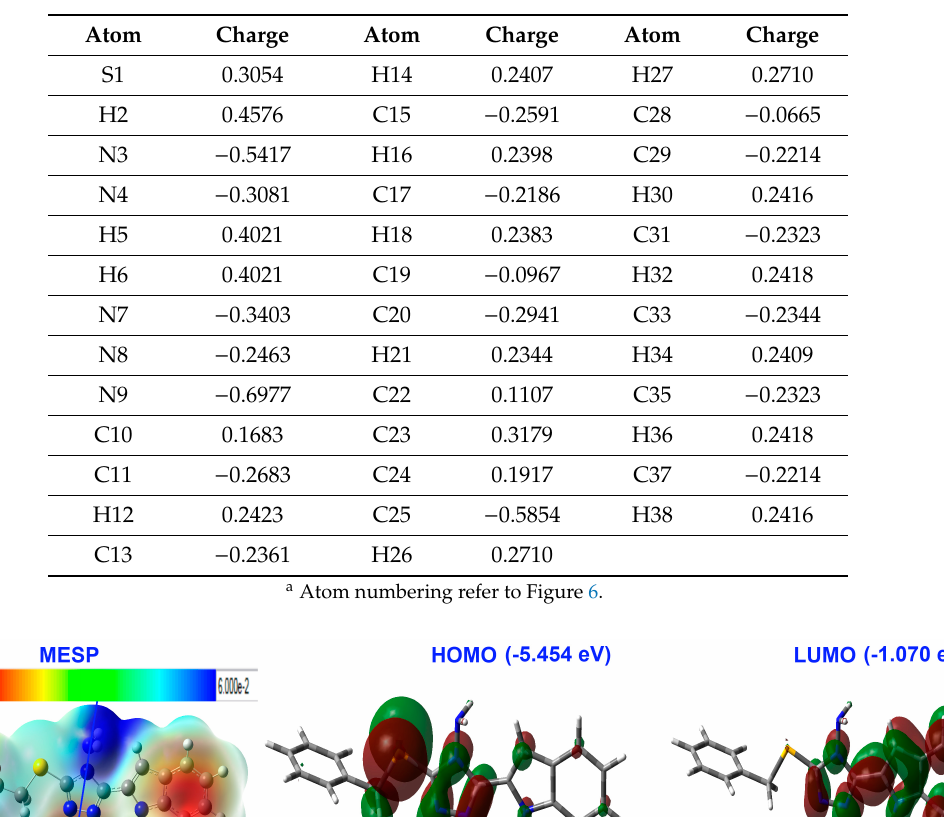
Figure 7. The straight-line correlations between the calculated and experimental bond distances ( a ) and angles ( b ).